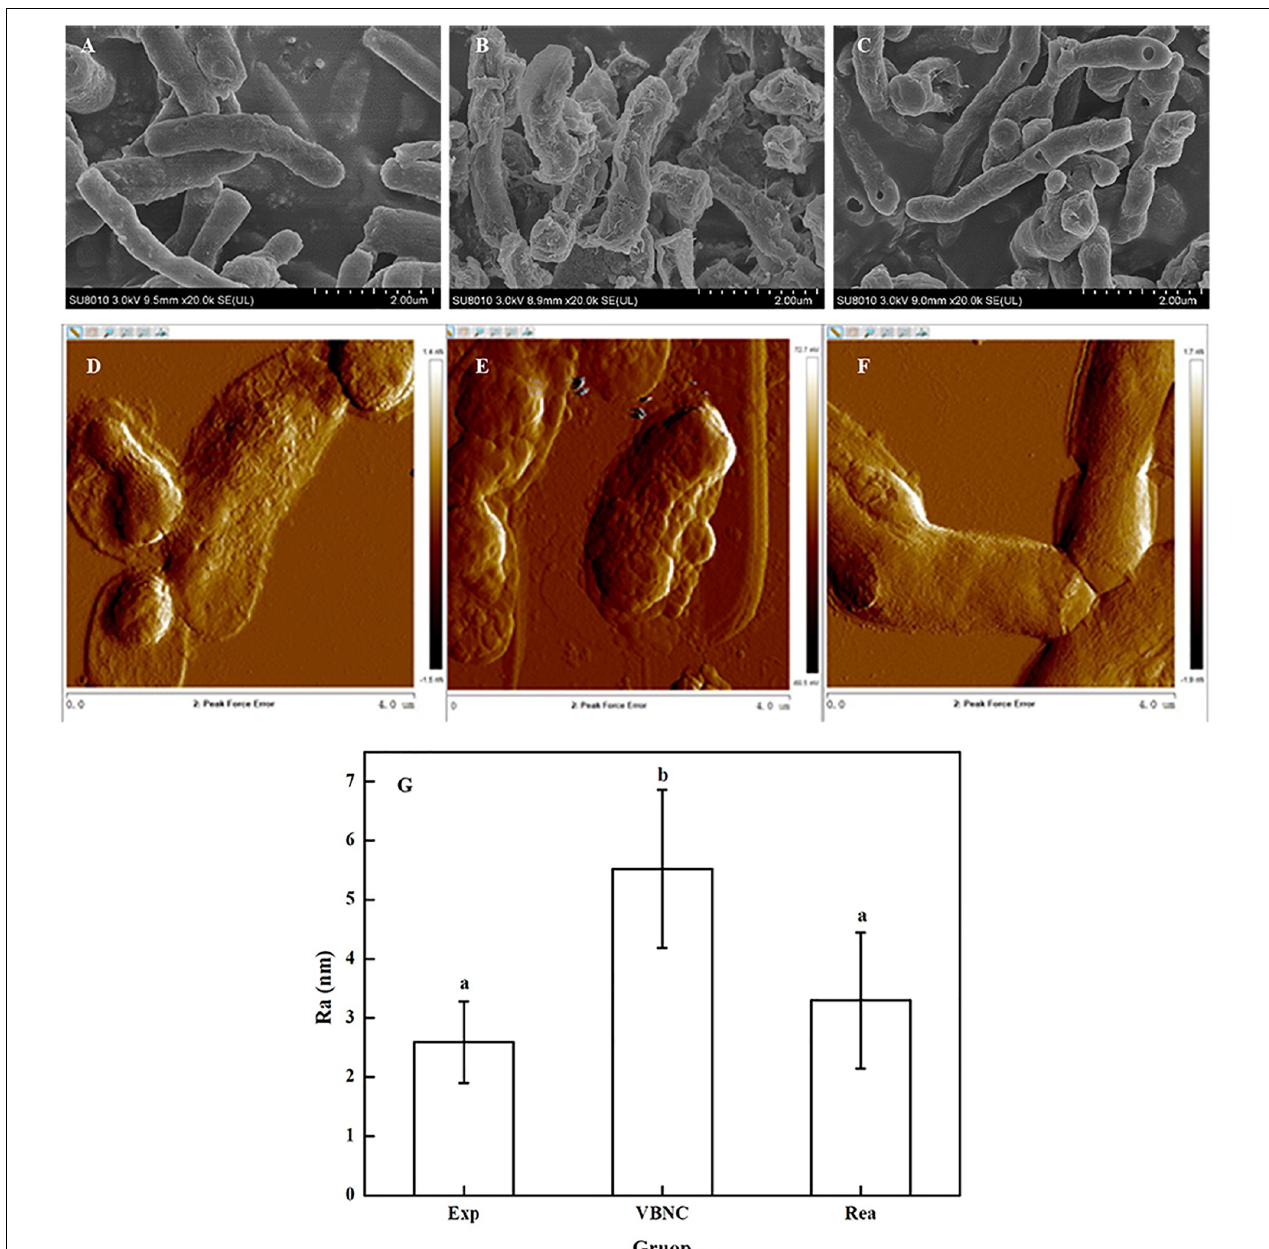
FIGURE 3 | Change in the surface roughness of the cells walls of R. biphenylivorans TG9 cells in the exponential phase, the VBNC state, and after resuscitation. SEM image of (A) exponential cells, (B) VBNC cells, and (C) resuscitated cells. AFM image of (D) exponential cells, (E) VBNC cells, and (F) resuscitated cells. (G) The roughness of the cell walls of R. biphenylivorans TG9 cells in the exponential phase, the VBNC state, and after resuscitation; Significant differences between means are indicated by different letters, p <